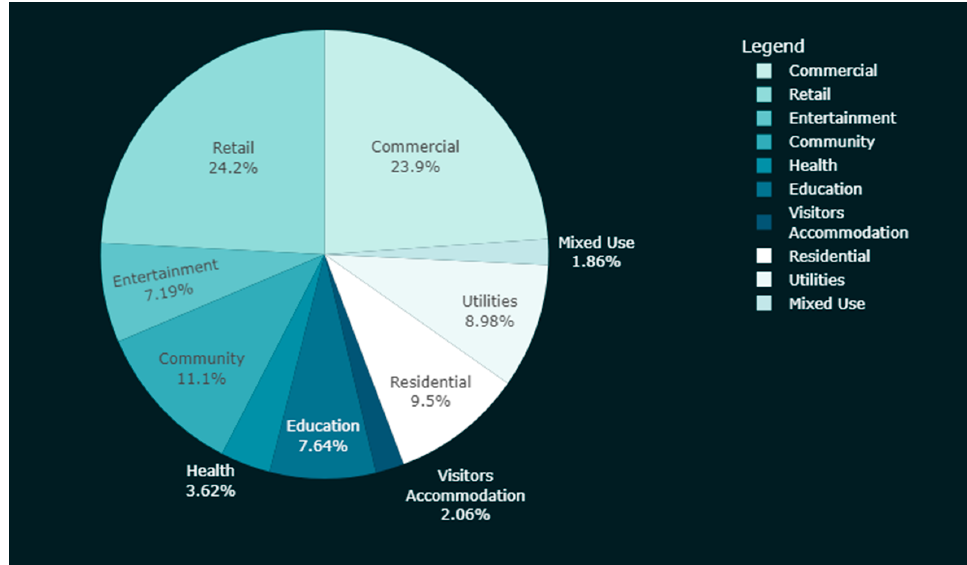
Figure 33. Proposed usage by total area of DAs (2004–2022).